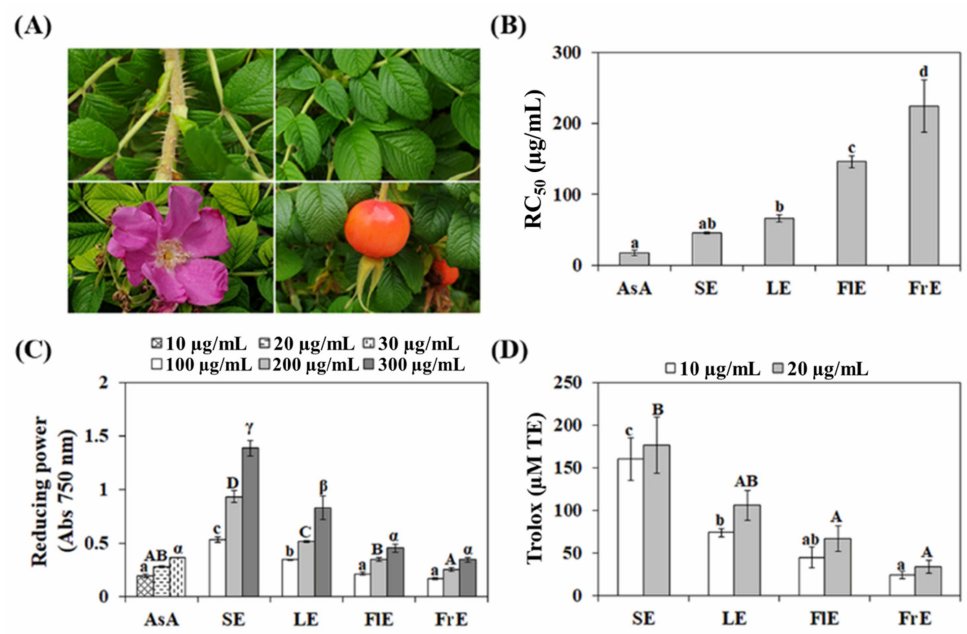
Figure 1. Morphology of R . rugosa and antioxidant activity of its organ extracts. Morphology of R . rugosa stems, leaves, flowers, and fruits ( A ). The antioxidant activities of R . rugosa organs were measured by DPPH-radical scavenging ( B ), reducing power ( C ), and ORAC ( D ) assays. The DPPH- radical scavenging activity was calculated and reported as RC50. The ORAC values of each organ extract were expressed as Trolox equivalents ( µ M TE). Different letters indicate that the means were significantly different at p < 0.05 (means ± SE of three independent experiments). Ascorbic acid, AsA; Stem extract, SE; leaf extract, LE; flower extract, FlE; fruit extract,